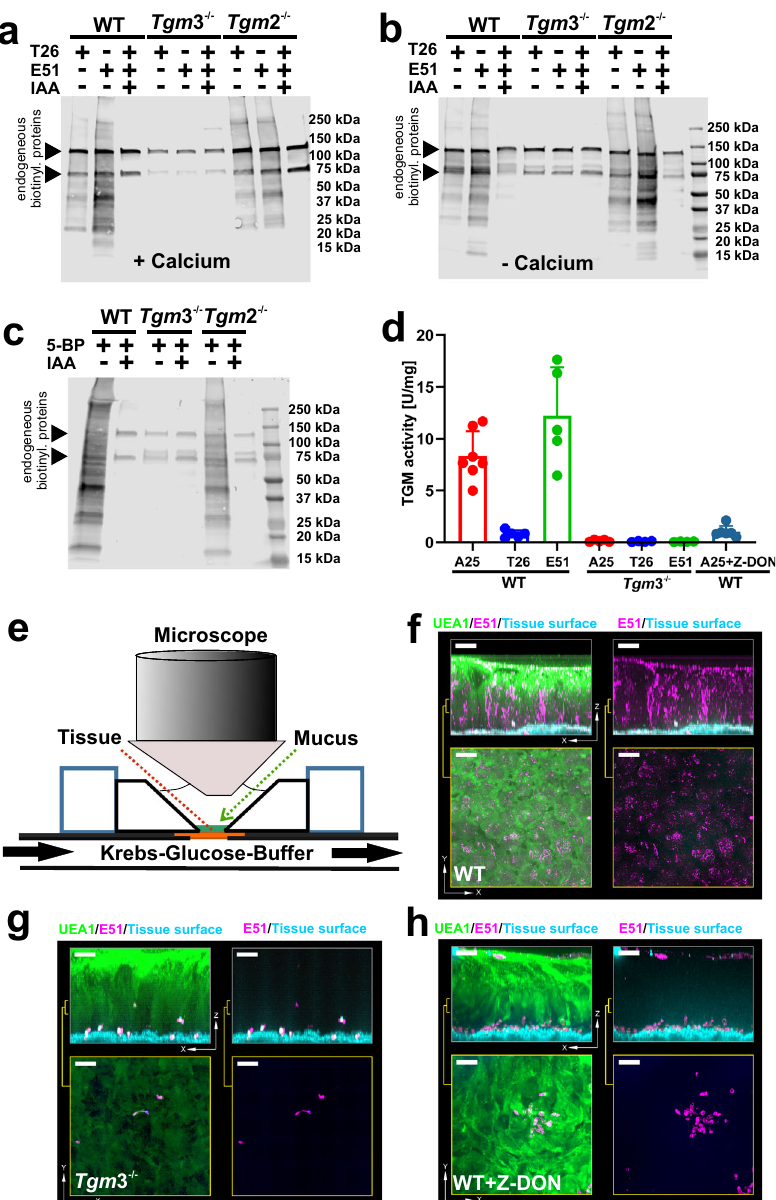
Fig. 2 Qualitative, quantitative and ex vivo analysis of extracellular transglutaminase activity. a Qualitative determination of calcium-induced transglutaminase activity in colonic mucus. Samples were treated with biotinylated-TGM2 and TGM3 acyl-donor substrates as described in the methods section. The reaction products were separated by SDS-PAGE and subsequently visualized by Western blot using IR680LT-labeled streptavidin on an infrared imager. Non-speci fi c signals from endogeneously biotinylated proteins were marked with a triangle. A representative example of three biological replicates per mouse strain is shown. b Qualitative determination of intrinsic transglutaminase activity in colonic mucus. The samples were treated and analyzed as described in ( a ) without calcium addition. A representative example of three animals per mouse strain is shown. c Detection of putative acyl- donor proteins in mucus. Samples from the different mouse strains were incubated in the presence of 5-Bioinyl-pentylamine (5-BP) for 1 h at 37 °C. Control reactions and detection of reaction products were performed as described in ( a ). n = 3. d Quantitative determination of transglutaminase activity in colonic mucus. TGM activity was determined by the incorporation of TGM2 (T26) and TGM3 (E51)-speci fi c peptides or a promiscuous acyl-donor peptide (A25) into casein as described in the “ Methods ” section and subsequent normalization against the respective protein concentration. Colored data points mark activities of individual animals ( n ≥ 4). Data present mean ± standard deviation. Source data are provided as a source data fi le. e – h Ex vivo analysis of transglutaminase activity. Tissues were mounted in a perfusion chamber as illustrated ( e ) and transglutaminase activity probed with the glutamine-donor peptide E51 coupled to FITC (magenta) for 30 min at 37 °C. After washing away non-incorporated peptide the tissue specimen were analyzed by confocal microscopy. Mucus and nuclei were counterstained with the UEA1 lectin coupled to rhodamine (green) and the Calcein violet stain (blue) respectively. The top panels show Z-stacks of the explant with (left) or without (right) the UEA1 counterstain. The bottom panels show x/y projections of the indicated area from the respective Z-stack on top. Colonic specimen from WT mice ( f ), Tgm3 − / − mice ( g ) or WT mice in the presence of the pan-TGM inhibitor Z-DON ( h ) were probed for E51 incorporation. The scale bar corresponds to 50 μ m. Three animals per mouse strain were